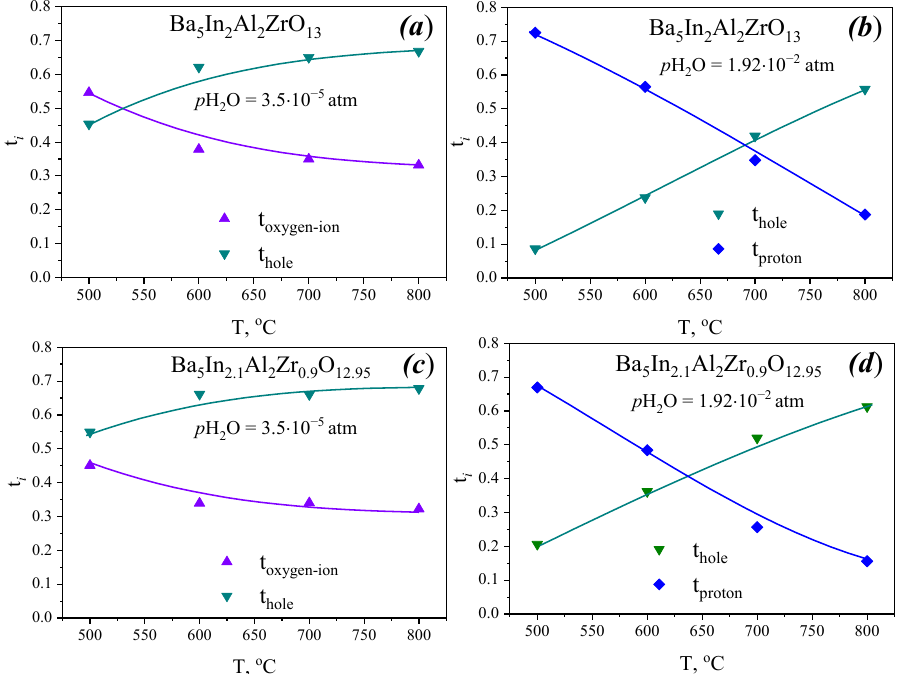
Figure 14. Transport numbers for Ba 5 In 2 Al 2 ZrO 13 in dry ( a ) and wet ( b ) air, and for Ba 5 In 2.1 Al 2 Zr 0.9 O 12.95 in dry ( c ) and wet ( d )